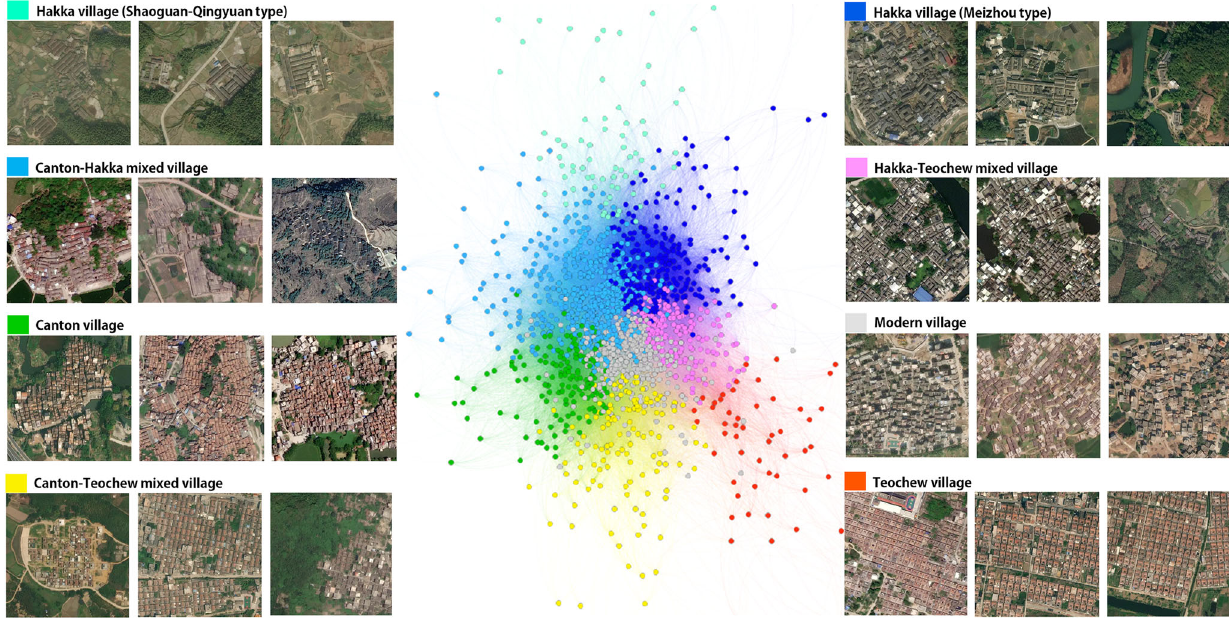
Fig. 6 The proximity network and the classical examples of each village style. Dots of the same color are grouped together to form clusters. This indicates that the distinguishing features of different ethnic types are captured. These classical examples of each styles are given by the data-driven clustering algorithm. And they all fi t to their corresponding ethnic styles according to the domain